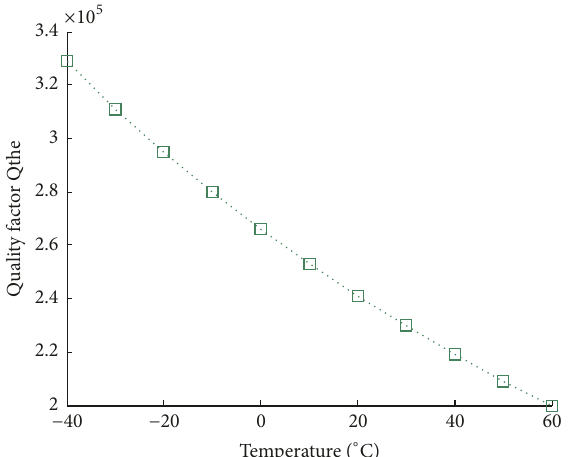
Figure 3: Q as a function of temperature. the